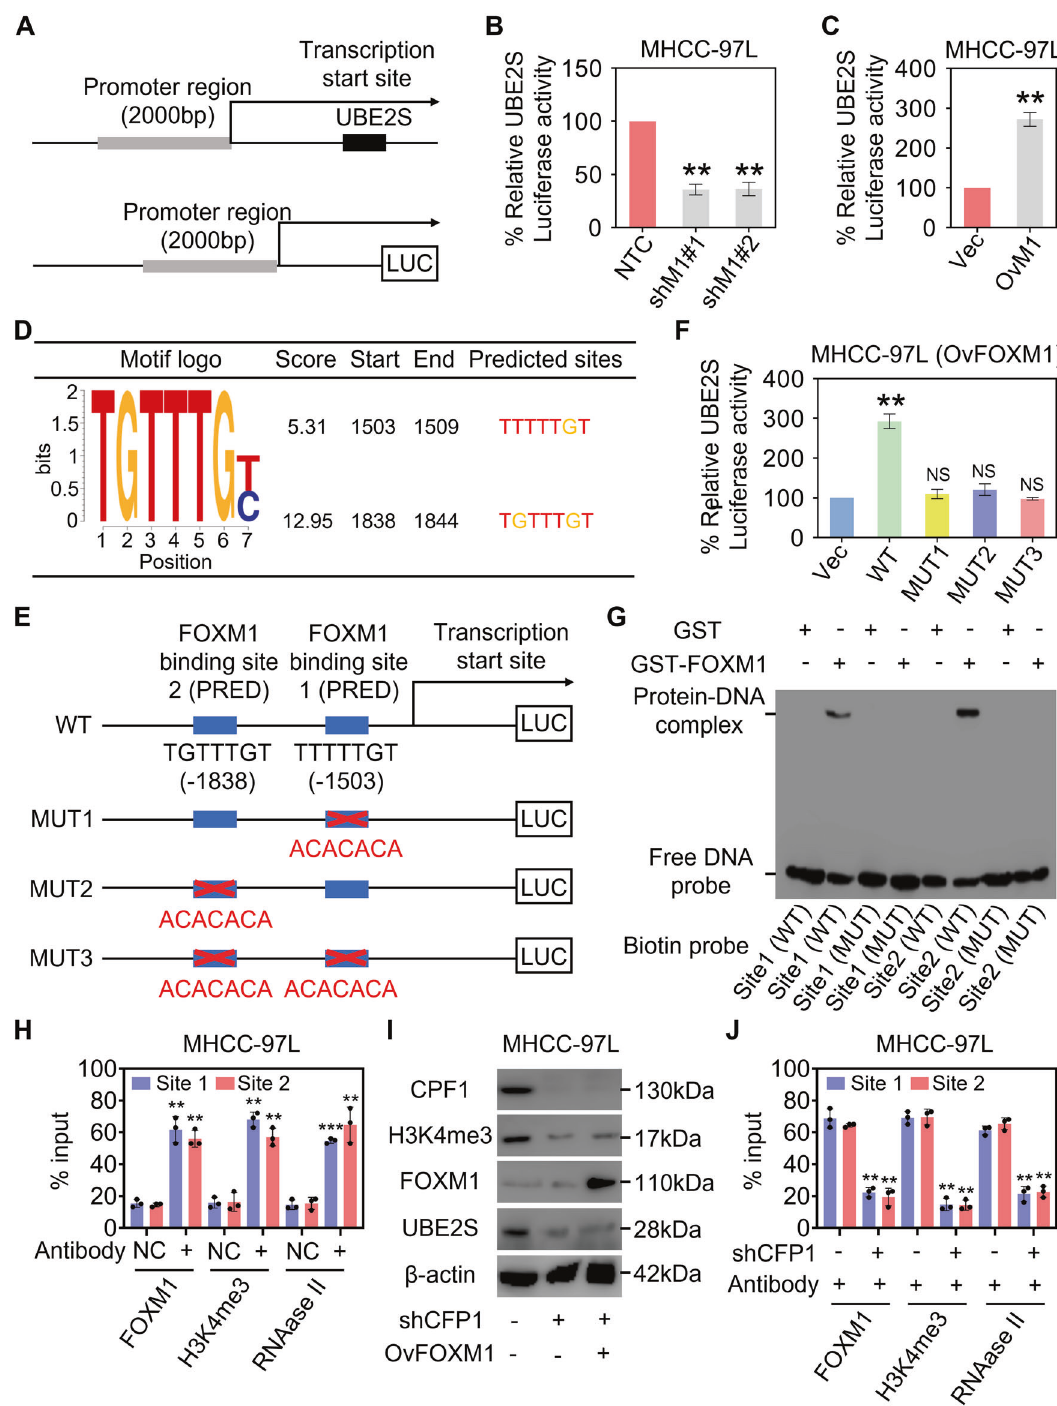
Fig. 4 UBE2S transcription is activated by the binding of FOXM1 to UBE2S promoter. A Schematic representation of UBE2S promoter. B , C MHCC-97L cells stably silenced FOXM1 ( B ) or overexpressed FOXM1 ( C ) were transfected with indicated UBE2S wild-type reporter plasmids, and the luciferase activity was measured, respectively ( n = 3). D , E Schematic representation of predicted FOXM1 binding sites ( D ) and corresponding mutated reporter constructs ( E ) for UBE2S. F FOXM1-overexpression MHCC-97L cells were transfected with indicated UBE2S wild-type (WT) or mutated reporter plasmids, and the luciferase activity was measured ( n = 3). G Biotin-labeled DNA probe from the two predicted FOXM1 binding sites of UBE2S promoter region or corresponding mutant probe was incubated with GST-FOXM1 protein, and the DNA-protein complexes were separated on 6% native polyacrylamide gels. H ChIP-qPCR assays for FOXM1, H3K4me3, and RNA- polymerase II binding sites in the promoter of UBE2S gene ( n = 3). I The protein levels of H3K4me3 and UBE2S were investigated in MHCC-97L cells stably silenced CPF1 together with FOXM1 overexpression. J ChIP-qPCR assays for FOXM1, H3K4me3, and RNA-polymerase II binding sites in the promoter of UBE2S gene in CPF1-knockdown MHCC-97L cells ( n = 3).